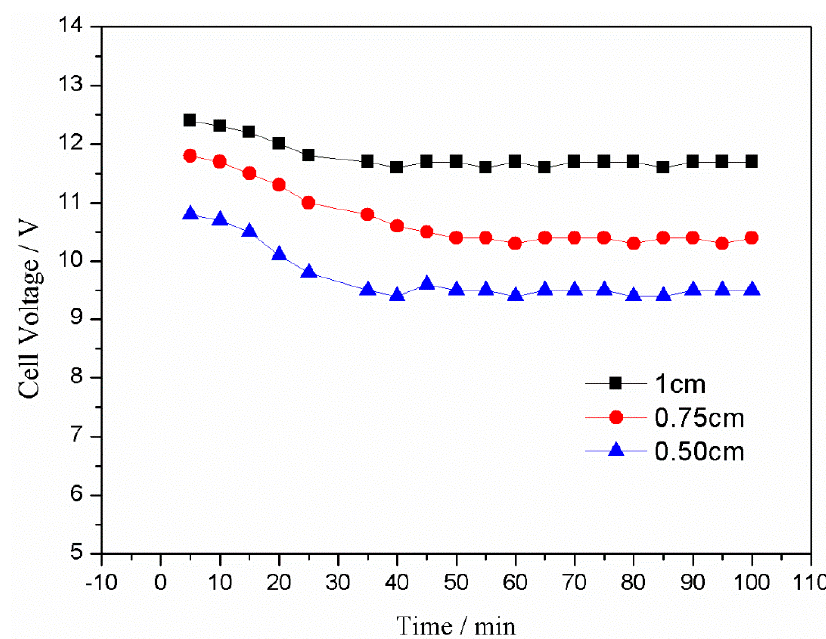
Figure 11. Change in cell voltage with electrode plate spacing.